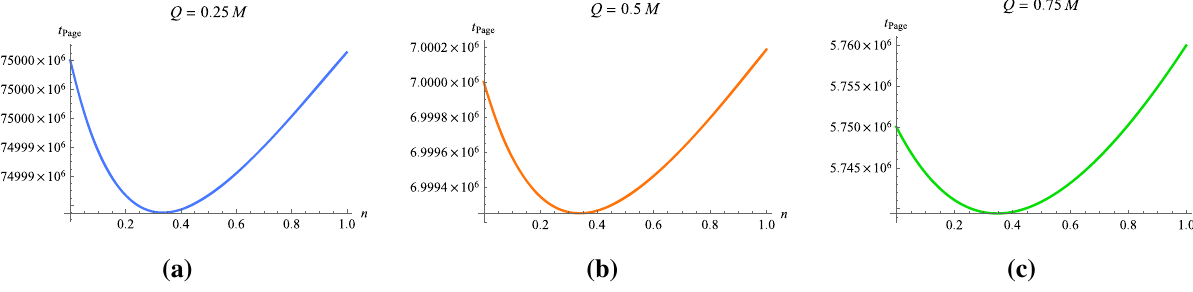
Fig. 5 The zoomed plots for Fig. 4a. The interval of the Page time varies with the stringy coefficient n is very small when the charge Q is small relative to the Mass